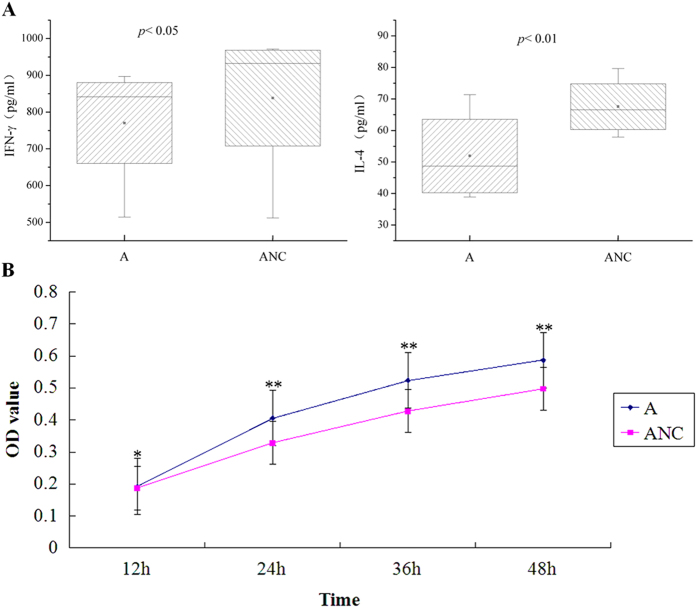
The proliferation activity as well as the IFN-γ and IL-4 levels in supernatant of EOLP CD4+ T cells transfected with agomir-155 (the details was illustrated as Fig. 3).